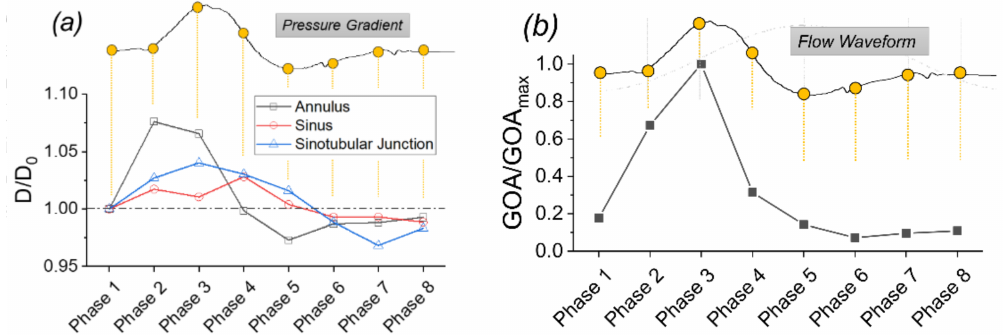
Figure 8. Deformation of the aortic root: ( a ) diameters at three sites; ( b ) the geometric orifice area of the valve during a cycle under the 4 L/min cardiac output.